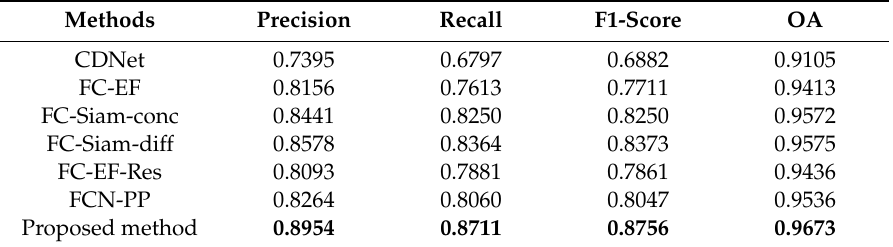
Table 2. Quantitative evaluation results of di ff erent approaches, where the best values are in